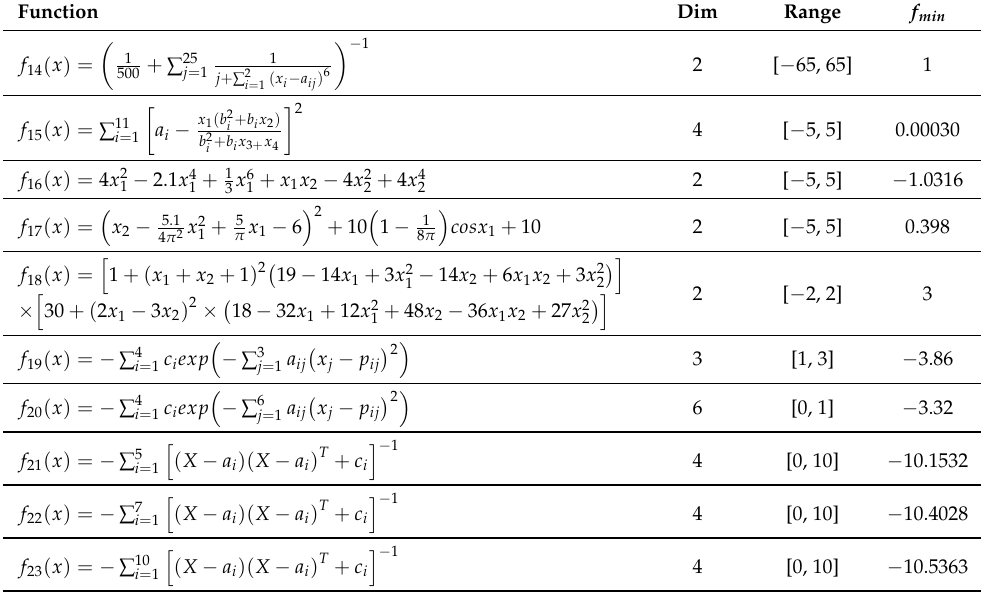
Table 6. Fixed-dimension multimodal benchmark function.